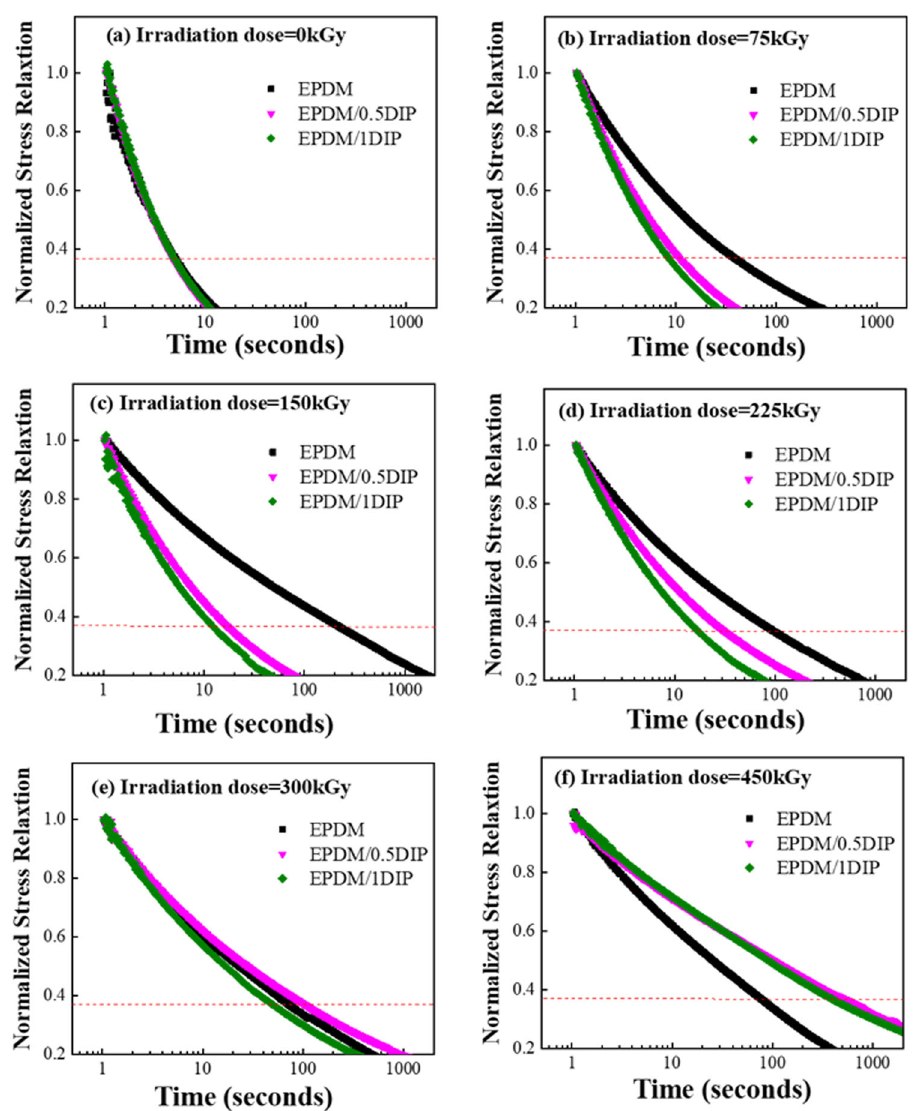
Fig. 6 Stress relaxation curves of the samples with different blend compositions at different γ -irradiation doses measured in air at 180 °C. a 0 kGy, b 75 kGy, c 150 kGy, d 225 kGy, e 300 kGy, f 450